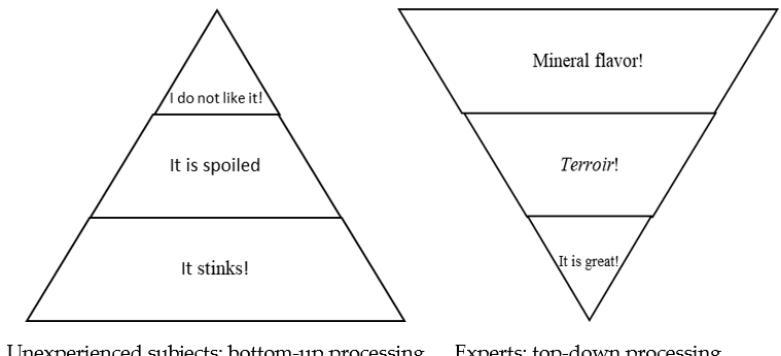
Figure 2. Hypothetical interpretation of a “mineral” white wine by experts or unexperienced sub- jects (novices or experts unaware of the reductive character) (adapted from Malfeito-Ferreira and Loureiro [47]).